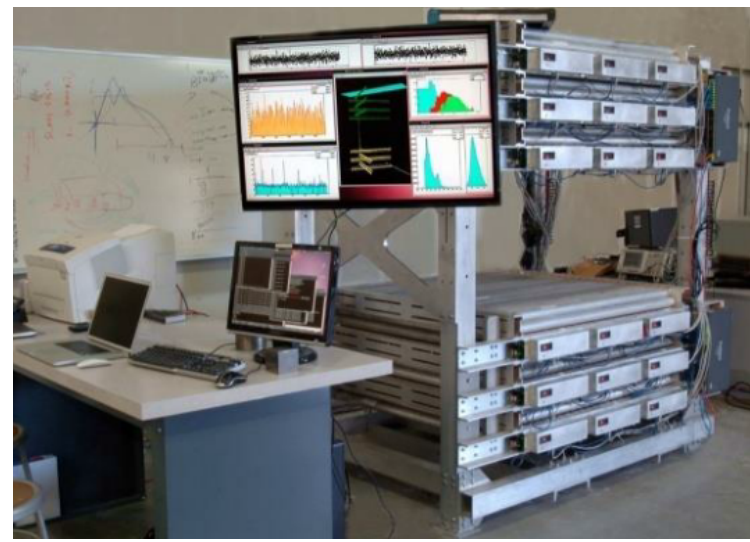
Figure 10. Photograph of the LANL muon station. Reproduced from [72].